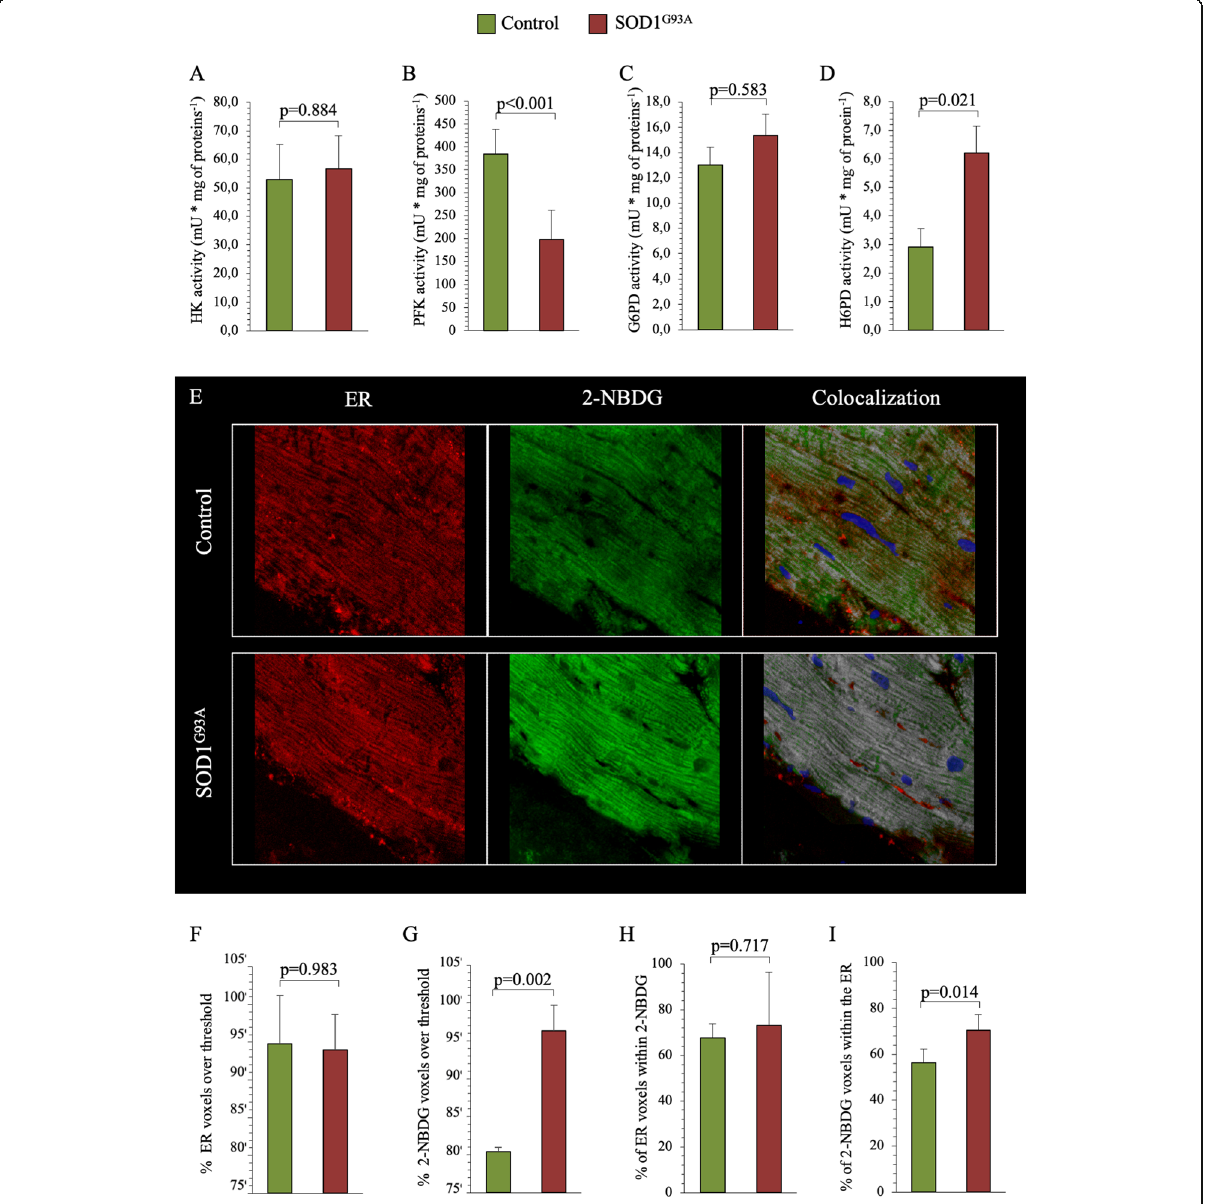
Fig. 3 Effect of SOD1 G93A mutation on enzymatic pathway and colocalization of 2-NBDG and ER signals in harvested quadriceps. a – d Respective activities of HK, PFK, G6PD, and H6PD in control (green column) and SOD1 G93A groups (red column) of quadriceps homogenate. e Immunofluorescence representative images of ER (red fluorescence), 2-NBDG (green fluorescence), and colocalization staining signals (% of 2-NBDG voxels within the ER staining — white) in control and SOD1 G93A quadriceps. Blue color reports the Hoechst 33342 signal. f , g Percent voxels over threshold of ER and 2-NBDG, respectively, in control and SOD1 G93A quadriceps. h Percent of ER voxels within 2-NBDG staining. i Percent of 2-NBDG voxels within ER staining. Data are expressed as mean ± SD, n = 3 for each group. Student t test for unpaired data was used for statistical